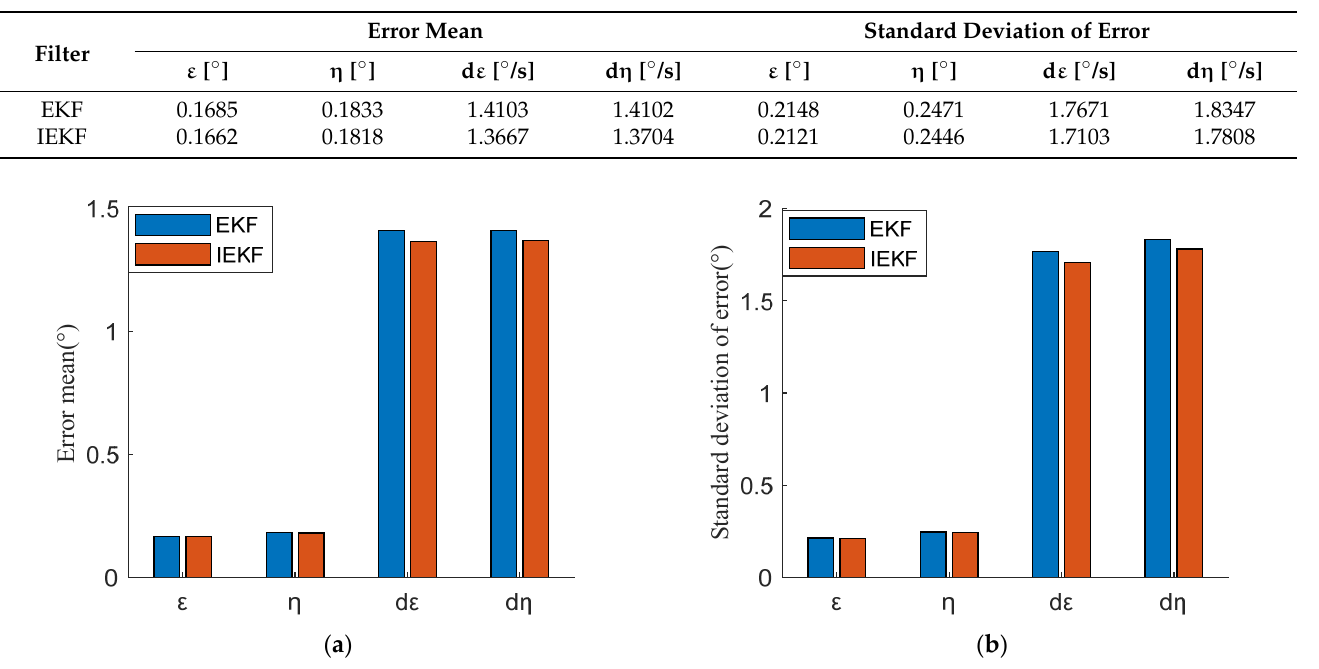
Figure 11. The error of EKF and IEKF. ( a ) The mean error. ( b ) The standard deviation. Table 2. The error means and standard deviations of error of EKF and IEKF.